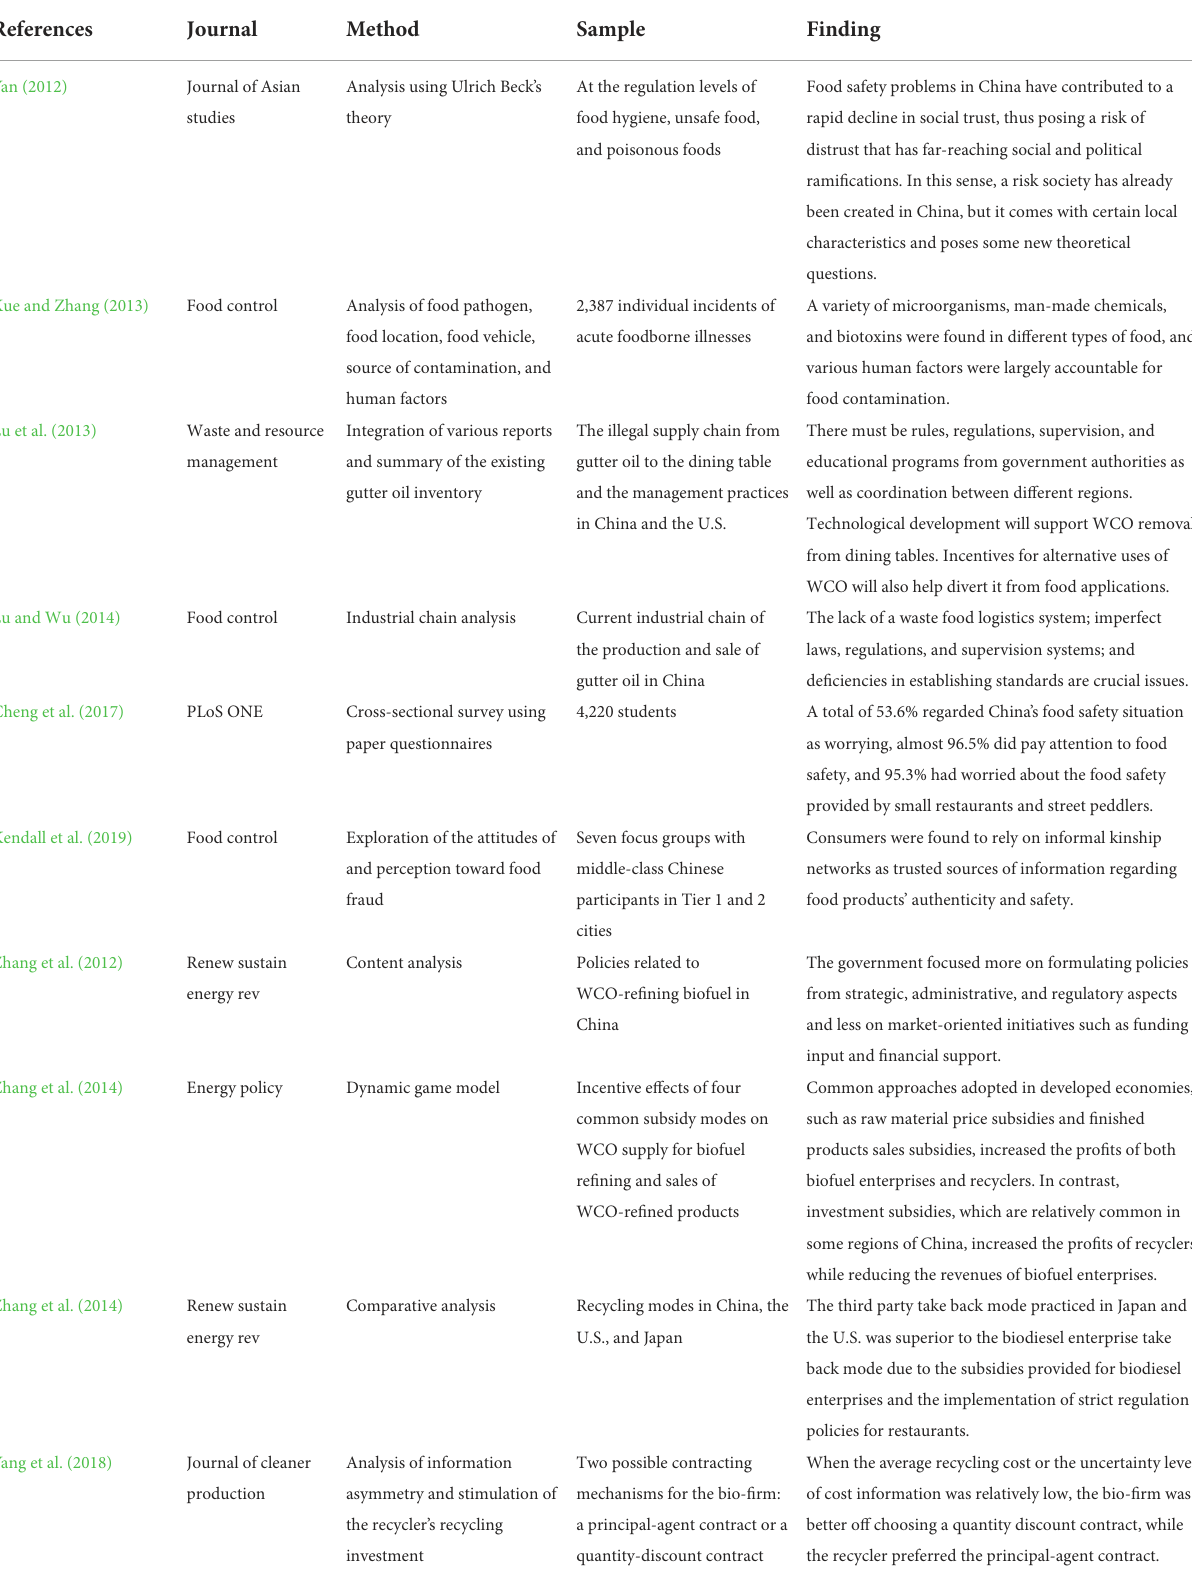
TABLE 3 Specific research trends in food safety and the relevant WCO research in